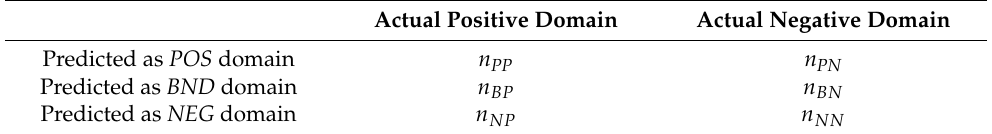
Table 5. Three-way decision confusion matrix. Actual Positive Domain Actual Negative Domain Predicted as POS domain n PP n PN Predicted as BND domain n BP n BN Predicted as NEG domain n NP n